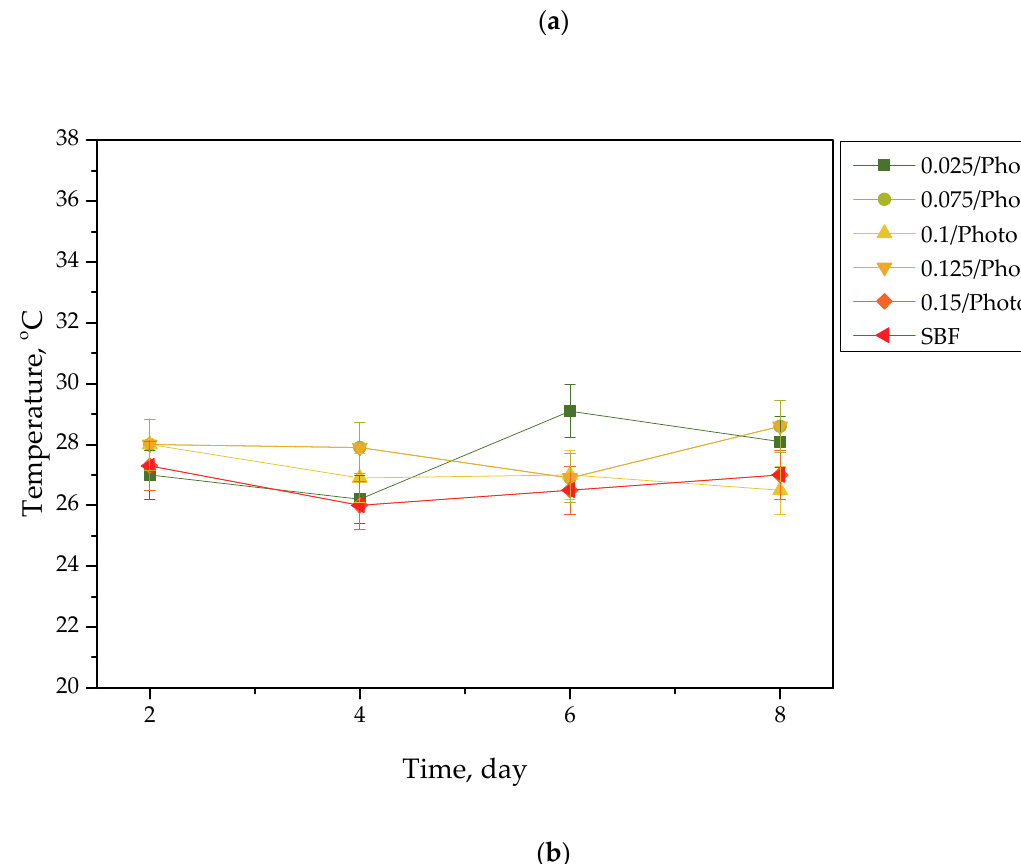
Figure 4. pH ( a ) and temperature ( b ) values of SBF, measured during the hydrogels’ incubation period (n = 3, n—number of repetitions).